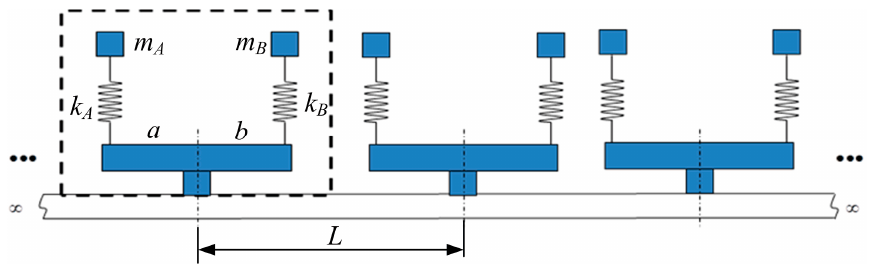
Figure 2. A beam with periodic uncoupled force-moment type resonators.